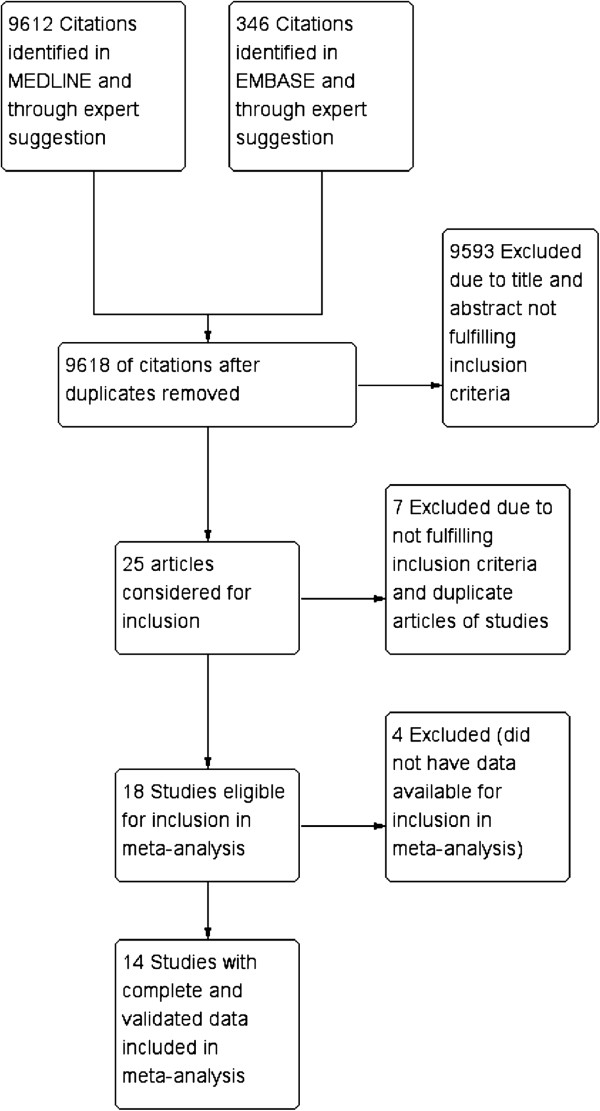
Study flow diagram.